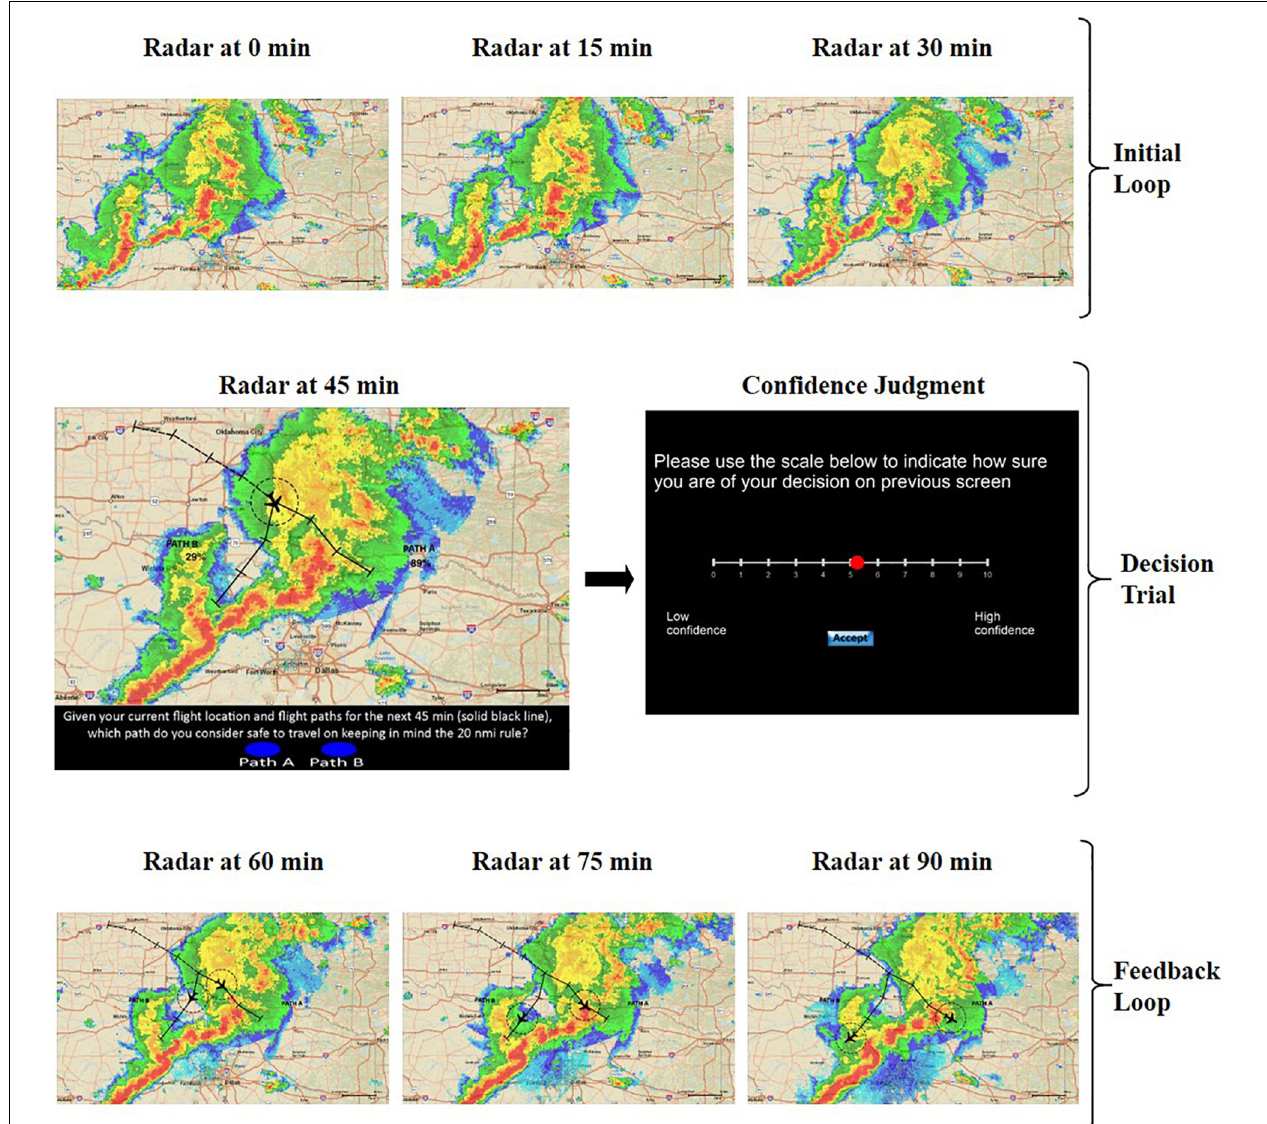
FIGURE 4 | Elicitation for double route trial in the training phase: Initial NEXRAD loop followed by decision trial and confidence judgment, and final feedback